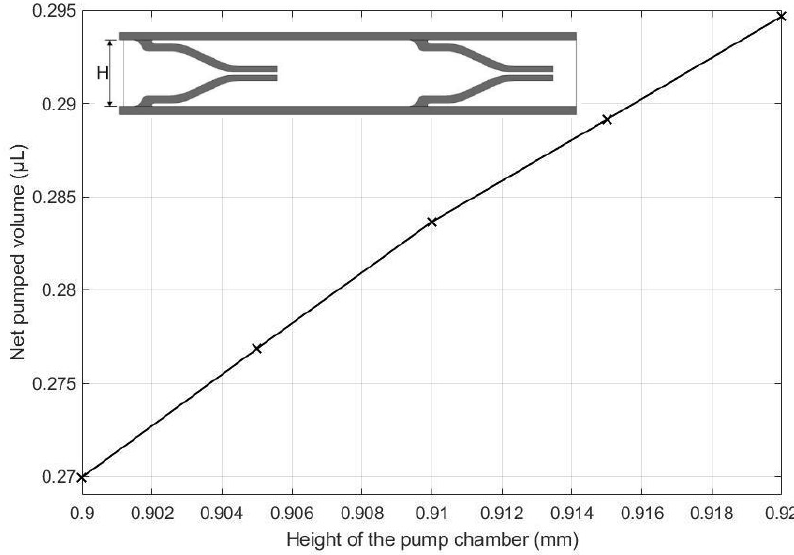
Figure 16. Effect of channel height on the net pumped volume.